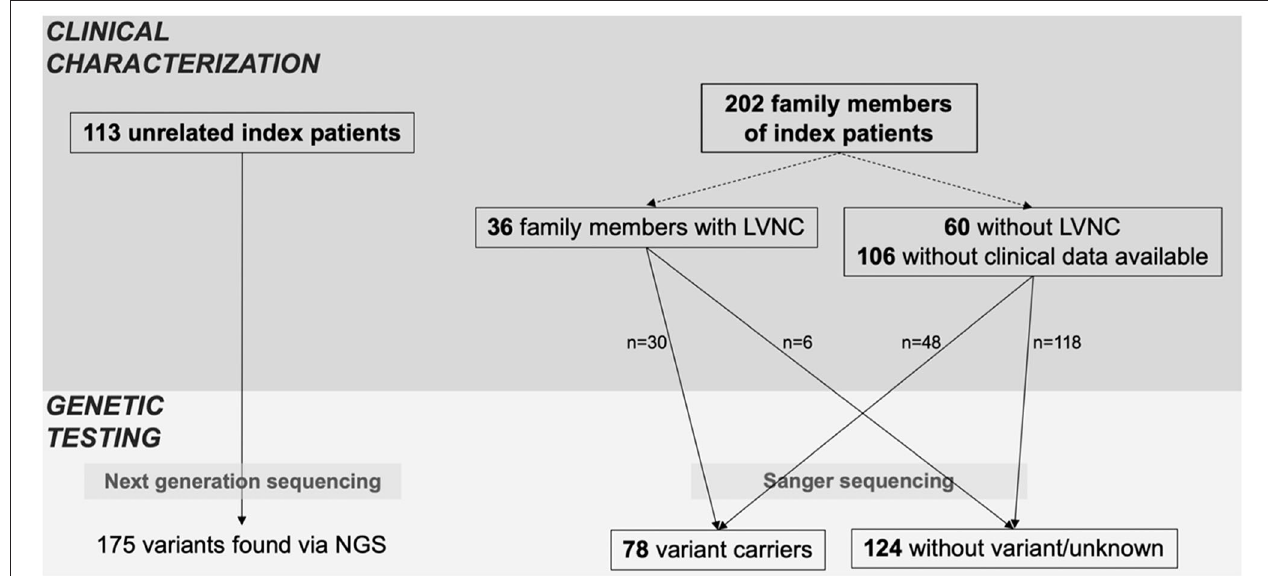
FIGURE 1 | Index patients and family screening. Overview of clinical characterization and genetic testing of patients, including all available family members. Family members were classified as variant carriers, when they carried at least one of the variants of the respective index patient.